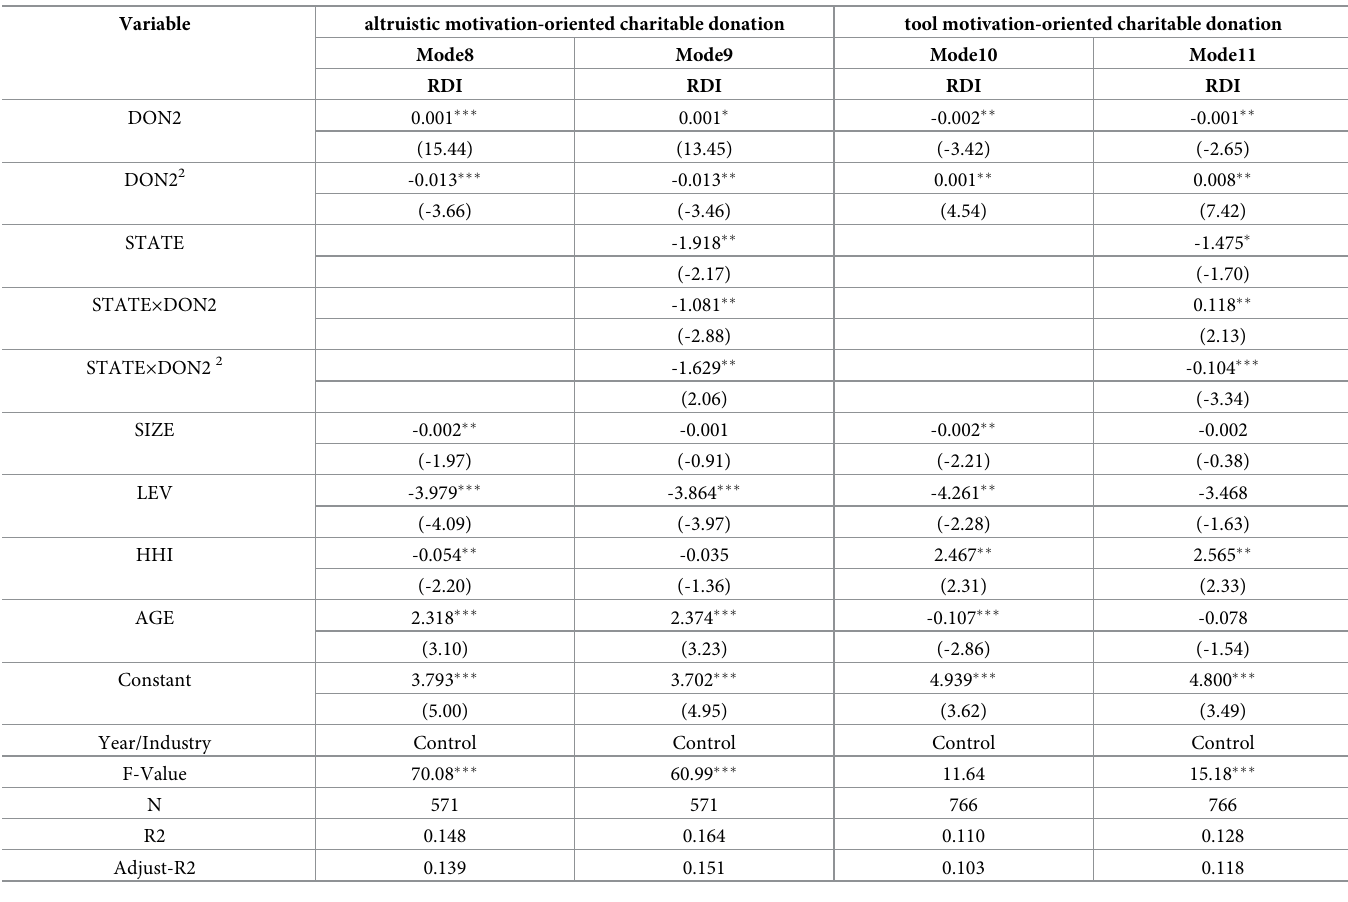
Table 6. Robustness